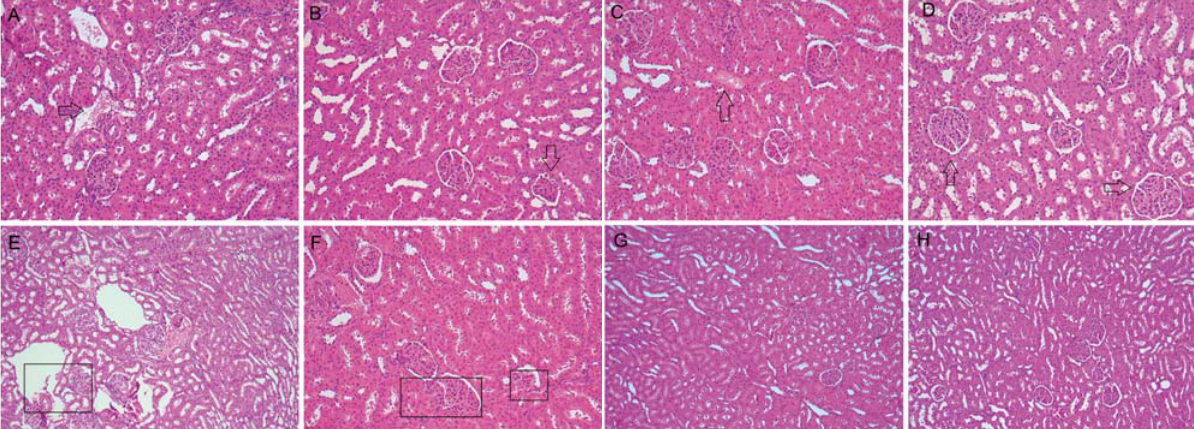
Figure 4- Photomicrographs of histological sections (5 μ m) of kidney stained with hematoxylin and eosin. (A) EBBO 7 d: We observed renal corpuscles containing preserved glomeruli, as well as intact proximal and distal tubule. However, note dilated and congested (cid:69)(cid:79)(cid:82)(cid:82)(cid:71)(cid:3)(cid:89)(cid:72)(cid:86)(cid:86)(cid:72)(cid:79)(cid:86)(cid:3)(cid:68)(cid:86)(cid:86)(cid:82)(cid:70)(cid:76)(cid:68)(cid:87)(cid:72)(cid:71)(cid:3)(cid:90)(cid:76)(cid:87)(cid:75)(cid:3)(cid:71)(cid:76)(cid:86)(cid:70)(cid:85)(cid:72)(cid:87)(cid:72)(cid:3)(cid:79)(cid:82)(cid:70)(cid:68)(cid:79)(cid:3)(cid:76)(cid:81)(cid:192)(cid:68)(cid:80)(cid:80)(cid:68)(cid:87)(cid:82)(cid:85)(cid:92)(cid:3)(cid:76)(cid:81)(cid:191)(cid:79)(cid:87)(cid:85)(cid:68)(cid:87)(cid:72)(cid:3)(cid:11)(cid:68)(cid:85)(cid:85)(cid:82)(cid:90)(cid:12)(cid:17)(cid:3)(cid:50)(cid:85)(cid:76)(cid:74)(cid:76)(cid:81)(cid:68)(cid:79)(cid:3)(cid:80)(cid:68)(cid:74)(cid:81)(cid:76)(cid:191)(cid:70)(cid:68)(cid:87)(cid:76)(cid:82)(cid:81)(cid:3)(cid:91)(cid:20)(cid:21)(cid:24)(cid:30)(cid:3)(cid:11)(cid:37)(cid:12)(cid:3)(cid:40)(cid:37)(cid:37)(cid:50)(cid:3)(cid:22)(cid:19)(cid:3)(cid:71)(cid:29)(cid:3)(cid:55)(cid:75)(cid:72)(cid:3)(cid:75)(cid:76)(cid:86)(cid:87)(cid:82)(cid:79)(cid:82)(cid:74)(cid:76)(cid:70)(cid:68)(cid:79)(cid:3) (cid:86)(cid:72)(cid:70)(cid:87)(cid:76)(cid:82)(cid:81)(cid:3)(cid:86)(cid:75)(cid:82)(cid:90)(cid:86)(cid:3)(cid:68)(cid:3)(cid:87)(cid:76)(cid:86)(cid:86)(cid:88)(cid:72)(cid:3)(cid:90)(cid:76)(cid:87)(cid:75)(cid:3)(cid:81)(cid:82)(cid:85)(cid:80)(cid:68)(cid:79)(cid:3)(cid:70)(cid:75)(cid:68)(cid:85)(cid:68)(cid:70)(cid:87)(cid:72)(cid:85)(cid:76)(cid:86)(cid:87)(cid:76)(cid:70)(cid:86)(cid:15)(cid:3)(cid:68)(cid:79)(cid:87)(cid:75)(cid:82)(cid:88)(cid:74)(cid:75)(cid:3)(cid:76)(cid:87)(cid:3)(cid:75)(cid:68)(cid:86)(cid:3)(cid:69)(cid:72)(cid:72)(cid:81)(cid:3)(cid:81)(cid:82)(cid:87)(cid:72)(cid:71)(cid:15)(cid:3)(cid:76)(cid:81)(cid:3)(cid:68)(cid:3)(cid:85)(cid:72)(cid:81)(cid:68)(cid:79)(cid:3)(cid:70)(cid:82)(cid:85)(cid:83)(cid:88)(cid:86)(cid:70)(cid:79)(cid:72)(cid:15)(cid:68)(cid:3)(cid:3)(cid:85)(cid:88)(cid:83)(cid:87)(cid:88)(cid:85)(cid:72)(cid:3)(cid:82)(cid:73)(cid:3)(cid:87)(cid:75)(cid:72)(cid:3)(cid:89)(cid:76)(cid:86)(cid:70)(cid:72)(cid:85)(cid:68)(cid:79)(cid:3)(cid:79)(cid:72)(cid:68)(cid:192)(cid:72)(cid:87)(cid:15)(cid:3)(cid:68)(cid:81)(cid:71)(cid:3)(cid:68)(cid:3) (cid:71)(cid:76)(cid:86)(cid:87)(cid:82)(cid:85)(cid:87)(cid:76)(cid:82)(cid:81)(cid:3)(cid:82)(cid:73)(cid:3)(cid:70)(cid:68)(cid:83)(cid:86)(cid:88)(cid:79)(cid:68)(cid:85)(cid:3)(cid:86)(cid:83)(cid:68)(cid:70)(cid:72)(cid:3)(cid:11)(cid:68)(cid:85)(cid:85)(cid:82)(cid:90)(cid:12)(cid:17)(cid:3)(cid:50)(cid:85)(cid:76)(cid:74)(cid:76)(cid:81)(cid:68)(cid:79)(cid:3)(cid:80)(cid:68)(cid:74)(cid:81)(cid:76)(cid:191)(cid:70)(cid:68)(cid:87)(cid:76)(cid:82)(cid:81)(cid:3)(cid:91)(cid:20)(cid:21)(cid:24)(cid:30)(cid:3)(cid:11)(cid:38)(cid:12)(cid:3)(cid:40)(cid:37)(cid:61)(cid:81)(cid:50)(cid:3)(cid:26)(cid:3)(cid:71)(cid:29)(cid:3)(cid:44)(cid:87)(cid:3)(cid:90)(cid:68)(cid:86)(cid:3)(cid:83)(cid:82)(cid:86)(cid:86)(cid:76)(cid:69)(cid:79)(cid:72)(cid:3)(cid:87)(cid:82)(cid:3)(cid:82)(cid:69)(cid:86)(cid:72)(cid:85)(cid:89)(cid:72)(cid:3)(cid:87)(cid:75)(cid:72)(cid:3)(cid:83)(cid:85)(cid:72)(cid:86)(cid:72)(cid:81)(cid:70)(cid:72)(cid:3)(cid:82)(cid:73)(cid:3)(cid:71)(cid:76)(cid:73)(cid:73)(cid:88)(cid:86)(cid:72)(cid:3)(cid:68)(cid:85)(cid:72)(cid:68)(cid:86)(cid:3) of hypercellularity and congested blood vessels (arrow) associated with the formation of numerous capillaries among the few mononuclear (cid:76)(cid:81)(cid:192)(cid:68)(cid:80)(cid:80)(cid:68)(cid:87)(cid:82)(cid:85)(cid:92)(cid:3)(cid:70)(cid:72)(cid:79)(cid:79)(cid:86)(cid:17)(cid:3)(cid:49)(cid:82)(cid:87)(cid:72)(cid:3)(cid:87)(cid:75)(cid:68)(cid:87)(cid:3)(cid:86)(cid:72)(cid:89)(cid:72)(cid:85)(cid:68)(cid:79)(cid:3)(cid:85)(cid:72)(cid:81)(cid:68)(cid:79)(cid:3)(cid:70)(cid:82)(cid:85)(cid:83)(cid:88)(cid:86)(cid:70)(cid:79)(cid:72)(cid:86)(cid:3)(cid:83)(cid:85)(cid:72)(cid:86)(cid:72)(cid:81)(cid:87)(cid:3)(cid:79)(cid:82)(cid:86)(cid:86)(cid:3)(cid:82)(cid:73)(cid:3)(cid:70)(cid:68)(cid:83)(cid:86)(cid:88)(cid:79)(cid:68)(cid:85)(cid:3)(cid:86)(cid:83)(cid:68)(cid:70)(cid:72)(cid:3)(cid:68)(cid:81)(cid:71)(cid:3)(cid:85)(cid:88)(cid:83)(cid:87)(cid:88)(cid:85)(cid:72)(cid:3)(cid:82)(cid:73)(cid:3)(cid:87)(cid:75)(cid:72)(cid:3)(cid:89)(cid:76)(cid:86)(cid:70)(cid:72)(cid:85)(cid:68)(cid:79)(cid:3)(cid:68)(cid:81)(cid:71)(cid:3)(cid:83)(cid:68)(cid:85)(cid:76)(cid:72)(cid:87)(cid:68)(cid:79)(cid:3)(cid:79)(cid:72)(cid:68)(cid:192)(cid:72)(cid:87)(cid:86)(cid:17)(cid:3) (cid:50)(cid:85)(cid:76)(cid:74)(cid:76)(cid:81)(cid:68)(cid:79)(cid:3)(cid:80)(cid:68)(cid:74)(cid:81)(cid:76)(cid:191)(cid:70)(cid:68)(cid:87)(cid:76)(cid:82)(cid:81)(cid:3)(cid:91)(cid:20)(cid:21)(cid:24)(cid:30)(cid:3)(cid:11)(cid:39)(cid:12)(cid:3)(cid:40)(cid:37)(cid:61)(cid:81)(cid:50)(cid:3)(cid:22)(cid:19)(cid:3)(cid:71)(cid:29)(cid:3)(cid:36)(cid:86)(cid:3)(cid:82)(cid:69)(cid:86)(cid:72)(cid:85)(cid:89)(cid:72)(cid:71)(cid:3)(cid:73)(cid:82)(cid:85)(cid:3)(cid:87)(cid:75)(cid:72)(cid:3)(cid:40)(cid:37)(cid:37)(cid:50)(cid:3)(cid:42)(cid:85)(cid:82)(cid:88)(cid:83)(cid:3)(cid:68)(cid:87)(cid:3)(cid:87)(cid:75)(cid:72)(cid:3)(cid:86)(cid:68)(cid:80)(cid:72)(cid:3)(cid:83)(cid:72)(cid:85)(cid:76)(cid:82)(cid:71)(cid:3)(cid:11)(cid:22)(cid:19)(cid:3)(cid:71)(cid:12)(cid:15)(cid:3)(cid:87)(cid:75)(cid:72)(cid:3)(cid:87)(cid:76)(cid:86)(cid:86)(cid:88)(cid:72)(cid:3)(cid:86)(cid:75)(cid:82)(cid:90)(cid:86)(cid:3)(cid:81)(cid:82)(cid:85)(cid:80)(cid:68)(cid:79)(cid:3) (cid:75)(cid:76)(cid:86)(cid:87)(cid:82)(cid:79)(cid:82)(cid:74)(cid:76)(cid:70)(cid:68)(cid:79)(cid:3)(cid:70)(cid:75)(cid:68)(cid:85)(cid:68)(cid:70)(cid:87)(cid:72)(cid:85)(cid:76)(cid:86)(cid:87)(cid:76)(cid:70)(cid:86)(cid:3)(cid:90)(cid:76)(cid:87)(cid:75)(cid:3)(cid:85)(cid:72)(cid:81)(cid:68)(cid:79)(cid:3)(cid:70)(cid:82)(cid:85)(cid:83)(cid:88)(cid:86)(cid:70)(cid:79)(cid:72)(cid:86)(cid:3)(cid:68)(cid:81)(cid:71)(cid:3)(cid:82)(cid:87)(cid:75)(cid:72)(cid:85)(cid:3)(cid:90)(cid:72)(cid:79)(cid:79)(cid:16)(cid:83)(cid:85)(cid:72)(cid:86)(cid:72)(cid:85)(cid:89)(cid:72)(cid:71)(cid:3)(cid:85)(cid:72)(cid:81)(cid:68)(cid:79)(cid:3)(cid:86)(cid:87)(cid:85)(cid:88)(cid:70)(cid:87)(cid:88)(cid:85)(cid:72)(cid:86)(cid:3)(cid:11)(cid:68)(cid:85)(cid:85)(cid:82)(cid:90)(cid:12)(cid:17)(cid:3)(cid:50)(cid:85)(cid:76)(cid:74)(cid:76)(cid:81)(cid:68)(cid:79)(cid:3)(cid:80)(cid:68)(cid:74)(cid:81)(cid:76)(cid:191)(cid:70)(cid:68)(cid:87)(cid:76)(cid:82)(cid:81)(cid:3)(cid:91)(cid:20)(cid:21)(cid:24)(cid:30)(cid:3)(cid:11)(cid:40)(cid:12)(cid:3)(cid:58)(cid:48)(cid:55)(cid:36)(cid:3) 7 d: The histological section shows several dilated blood vessels and endothelial disruption (box), characterizing areas of hemorrhage and wide edema formation. Note hydropic degeneration of cells that comprise the distal and proximal tubules, which appear distorted (cid:68)(cid:81)(cid:71)(cid:3)(cid:71)(cid:76)(cid:86)(cid:82)(cid:85)(cid:74)(cid:68)(cid:81)(cid:76)(cid:93)(cid:72)(cid:71)(cid:17)(cid:3)(cid:44)(cid:87)(cid:3)(cid:76)(cid:86)(cid:3)(cid:68)(cid:79)(cid:86)(cid:82)(cid:3)(cid:83)(cid:82)(cid:86)(cid:86)(cid:76)(cid:69)(cid:79)(cid:72)(cid:3)(cid:87)(cid:82)(cid:3)(cid:71)(cid:72)(cid:87)(cid:72)(cid:70)(cid:87)(cid:3)(cid:80)(cid:68)(cid:81)(cid:92)(cid:3)(cid:85)(cid:72)(cid:81)(cid:68)(cid:79)(cid:3)(cid:70)(cid:82)(cid:85)(cid:83)(cid:88)(cid:86)(cid:70)(cid:79)(cid:72)(cid:86)(cid:3)(cid:90)(cid:76)(cid:87)(cid:75)(cid:3)(cid:85)(cid:88)(cid:83)(cid:87)(cid:88)(cid:85)(cid:72)(cid:71)(cid:3)(cid:89)(cid:76)(cid:86)(cid:70)(cid:72)(cid:85)(cid:68)(cid:79)(cid:3)(cid:68)(cid:81)(cid:71)(cid:3)(cid:83)(cid:68)(cid:85)(cid:76)(cid:72)(cid:87)(cid:68)(cid:79)(cid:3)(cid:79)(cid:72)(cid:68)(cid:192)(cid:72)(cid:87)(cid:86)(cid:15)(cid:3)(cid:68)(cid:81)(cid:71)(cid:3)(cid:76)(cid:81)(cid:192)(cid:68)(cid:80)(cid:80)(cid:68)(cid:87)(cid:82)(cid:85)(cid:92)(cid:3)(cid:70)(cid:72)(cid:79)(cid:79)(cid:86)(cid:3)(cid:76)(cid:81)(cid:3) (cid:87)(cid:75)(cid:72)(cid:3)(cid:74)(cid:79)(cid:82)(cid:80)(cid:72)(cid:85)(cid:88)(cid:79)(cid:76)(cid:17)(cid:3)(cid:50)(cid:85)(cid:76)(cid:74)(cid:76)(cid:81)(cid:68)(cid:79)(cid:3)(cid:80)(cid:68)(cid:74)(cid:81)(cid:76)(cid:191)(cid:70)(cid:68)(cid:87)(cid:76)(cid:82)(cid:81)(cid:3)(cid:91)(cid:20)(cid:21)(cid:24)(cid:30)(cid:3)(cid:11)(cid:41)(cid:12)(cid:3)(cid:58)(cid:48)(cid:55)(cid:36)(cid:3)(cid:22)(cid:19)(cid:3)(cid:71)(cid:29)(cid:3)(cid:39)(cid:72)(cid:86)(cid:83)(cid:76)(cid:87)(cid:72)(cid:3)(cid:87)(cid:75)(cid:72)(cid:3)(cid:85)(cid:72)(cid:81)(cid:68)(cid:79)(cid:3)(cid:70)(cid:82)(cid:85)(cid:83)(cid:88)(cid:86)(cid:70)(cid:79)(cid:72)(cid:86)(cid:15)(cid:3)(cid:68)(cid:3)(cid:69)(cid:72)(cid:87)(cid:87)(cid:72)(cid:85)(cid:3)(cid:82)(cid:85)(cid:74)(cid:68)(cid:81)(cid:76)(cid:93)(cid:72)(cid:71)(cid:3)(cid:86)(cid:87)(cid:85)(cid:88)(cid:70)(cid:87)(cid:88)(cid:85)(cid:72)(cid:3)(cid:11)(cid:69)(cid:82)(cid:91)(cid:12)(cid:15)(cid:3)(cid:76)(cid:87)(cid:3)(cid:76)(cid:86)(cid:3)(cid:83)(cid:82)(cid:86)(cid:86)(cid:76)(cid:69)(cid:79)(cid:72)(cid:3) to observe the persistence of numerous congested blood vessels. Note that the proximal and distal tubules are better constituted and (cid:71)(cid:76)(cid:86)(cid:87)(cid:85)(cid:76)(cid:69)(cid:88)(cid:87)(cid:72)(cid:71)(cid:17)(cid:3)(cid:55)(cid:75)(cid:72)(cid:86)(cid:72)(cid:3)(cid:73)(cid:72)(cid:68)(cid:87)(cid:88)(cid:85)(cid:72)(cid:86)(cid:3)(cid:71)(cid:72)(cid:80)(cid:82)(cid:81)(cid:86)(cid:87)(cid:85)(cid:68)(cid:87)(cid:72)(cid:3)(cid:87)(cid:75)(cid:68)(cid:87)(cid:3)(cid:87)(cid:75)(cid:72)(cid:3)(cid:78)(cid:76)(cid:71)(cid:81)(cid:72)(cid:92)(cid:3)(cid:76)(cid:86)(cid:3)(cid:76)(cid:81)(cid:3)(cid:70)(cid:82)(cid:81)(cid:87)(cid:76)(cid:81)(cid:88)(cid:82)(cid:88)(cid:86)(cid:3)(cid:83)(cid:85)(cid:82)(cid:70)(cid:72)(cid:86)(cid:86)(cid:3)(cid:82)(cid:73)(cid:3)(cid:87)(cid:76)(cid:86)(cid:86)(cid:88)(cid:72)(cid:3)(cid:85)(cid:72)(cid:83)(cid:68)(cid:76)(cid:85)(cid:17)(cid:3)(cid:50)(cid:85)(cid:76)(cid:74)(cid:76)(cid:81)(cid:68)(cid:79)(cid:3)(cid:80)(cid:68)(cid:74)(cid:81)(cid:76)(cid:191)(cid:70)(cid:68)(cid:87)(cid:76)(cid:82)(cid:81)(cid:3)(cid:91)(cid:20)(cid:21)(cid:24)(cid:30)(cid:3)(cid:11)(cid:42)(cid:3)(cid:68)(cid:81)(cid:71)(cid:3)(cid:43)(cid:12)(cid:3) Control 7 and 30 d: The histological section shows a tissue with normal histological characteristics. It is possible to observe several renal (cid:70)(cid:82)(cid:85)(cid:83)(cid:88)(cid:86)(cid:70)(cid:79)(cid:72)(cid:86)(cid:3)(cid:90)(cid:76)(cid:87)(cid:75)(cid:3)(cid:82)(cid:85)(cid:74)(cid:68)(cid:81)(cid:76)(cid:93)(cid:72)(cid:71)(cid:3)(cid:74)(cid:79)(cid:82)(cid:80)(cid:72)(cid:85)(cid:88)(cid:79)(cid:88)(cid:86)(cid:15)(cid:3)(cid:68)(cid:86)(cid:3)(cid:90)(cid:72)(cid:79)(cid:79)(cid:3)(cid:68)(cid:86)(cid:3)(cid:76)(cid:81)(cid:87)(cid:68)(cid:70)(cid:87)(cid:3)(cid:83)(cid:68)(cid:85)(cid:76)(cid:72)(cid:87)(cid:68)(cid:79)(cid:3)(cid:68)(cid:81)(cid:71)(cid:3)(cid:89)(cid:76)(cid:86)(cid:70)(cid:72)(cid:85)(cid:68)(cid:79)(cid:3)(cid:79)(cid:72)(cid:68)(cid:192)(cid:72)(cid:87)(cid:86)(cid:3)(cid:83)(cid:85)(cid:72)(cid:86)(cid:72)(cid:85)(cid:89)(cid:76)(cid:81)(cid:74)(cid:3)(cid:87)(cid:75)(cid:72)(cid:3)(cid:70)(cid:68)(cid:83)(cid:86)(cid:88)(cid:79)(cid:68)(cid:85)(cid:3)(cid:86)(cid:83)(cid:68)(cid:70)(cid:72)(cid:17)(cid:3)(cid:49)(cid:82)(cid:87)(cid:72)(cid:3)(cid:87)(cid:75)(cid:72)(cid:3)(cid:83)(cid:85)(cid:72)(cid:86)(cid:72)(cid:81)(cid:70)(cid:72)(cid:3)(cid:82)(cid:73)(cid:3)